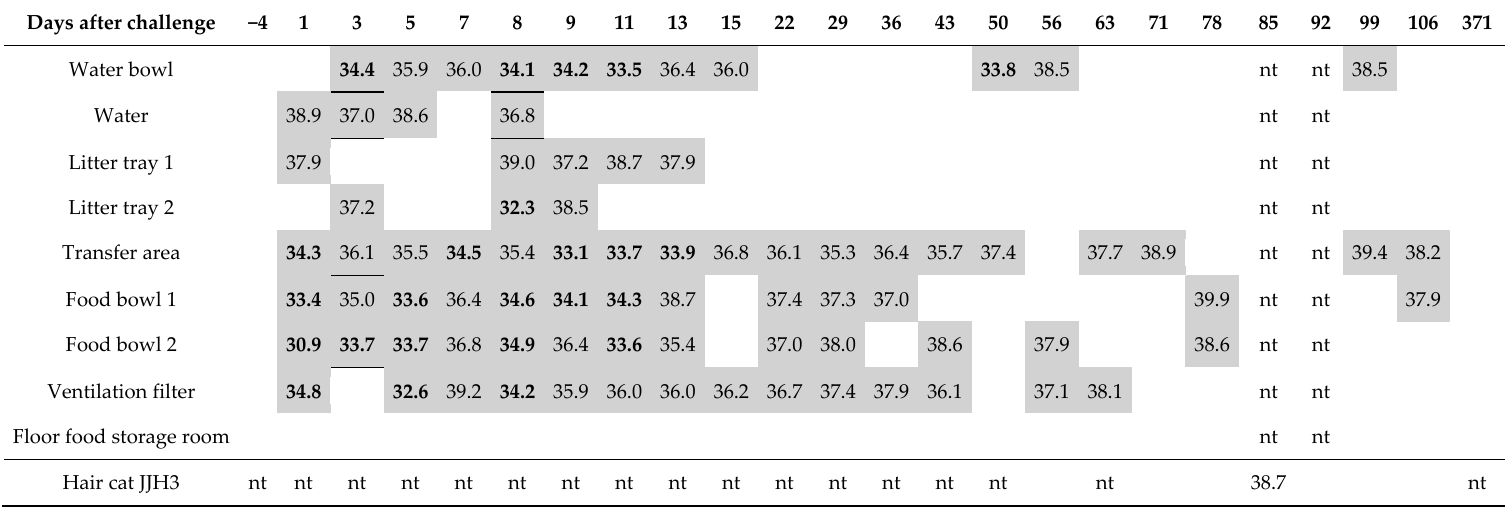
Table 2. Testing for environmental and hair contamination by FCV by RT-PCR after the first experimental infection with FCV 273.